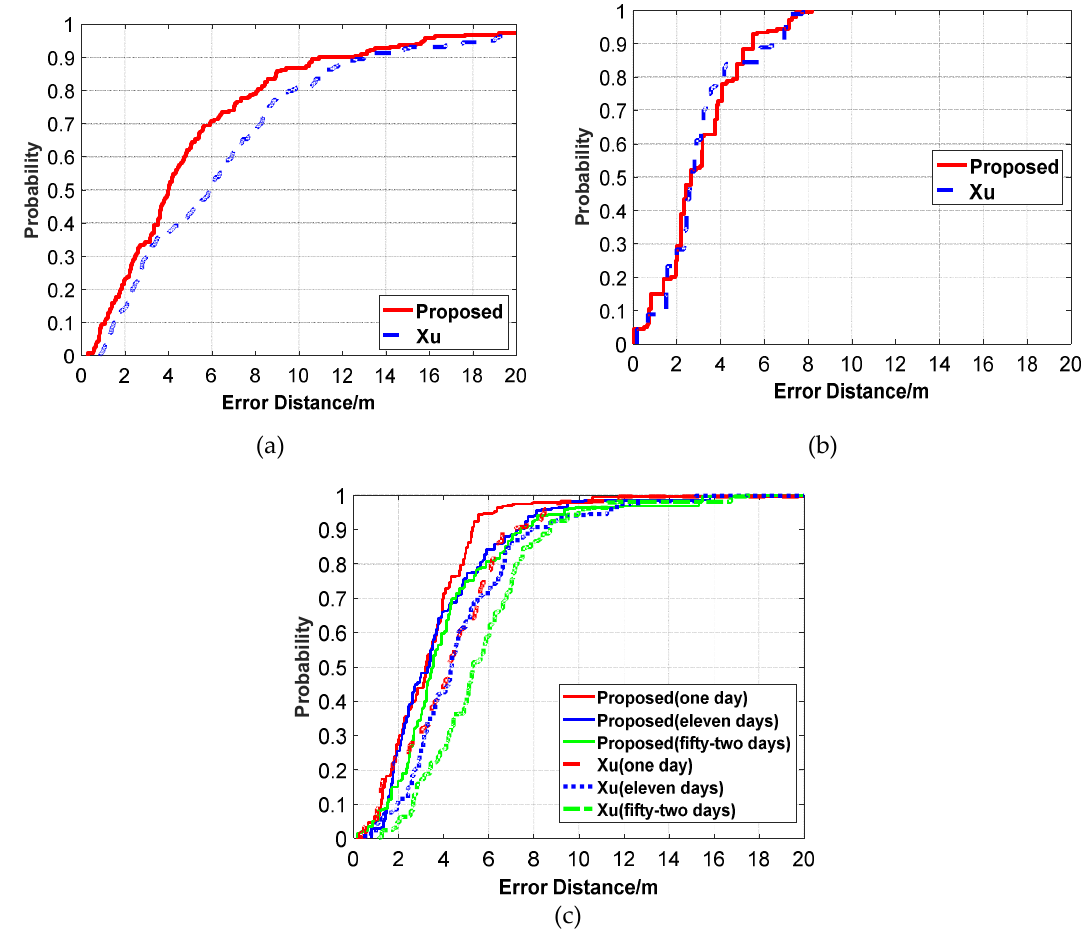
Figure 25. Comparison of CDF positioning errors between the proposed algorithm and Xu on different datasets. ( a ) Dataset1. ( b ) Dataset2. ( c ) Dataset3. Table 8. Comparison of the average positioning errors between the proposed algorithm and Xu. Dataset